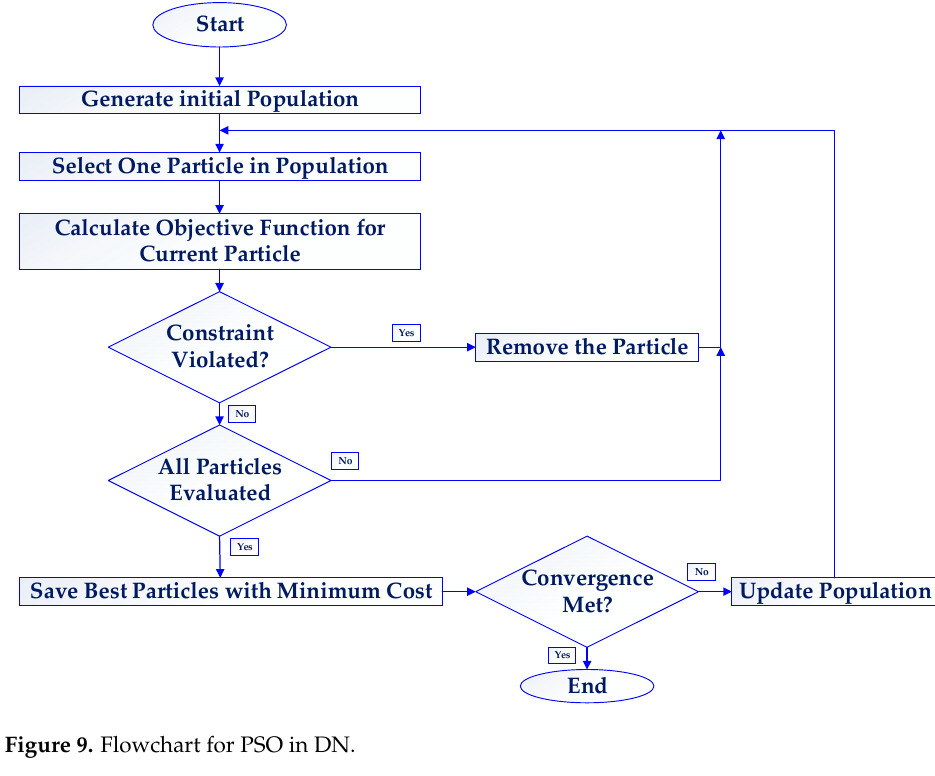
Figure 9. Flowchart for PSO in DN. Table 3. Comparison of methods for DN planning available in the